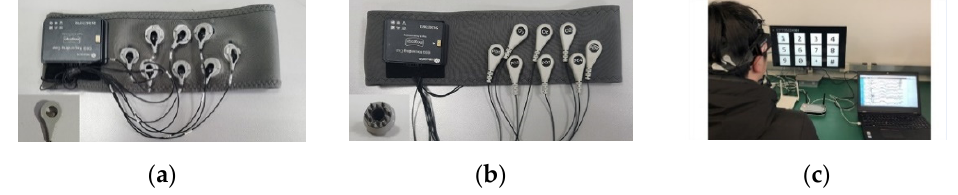
Figure 2. The 8-channel wireless EEG headband with ( a ) wet and ( b ) dry electrodes. ( c ) A subject wearing the headband in the 12-target BCI experiment.